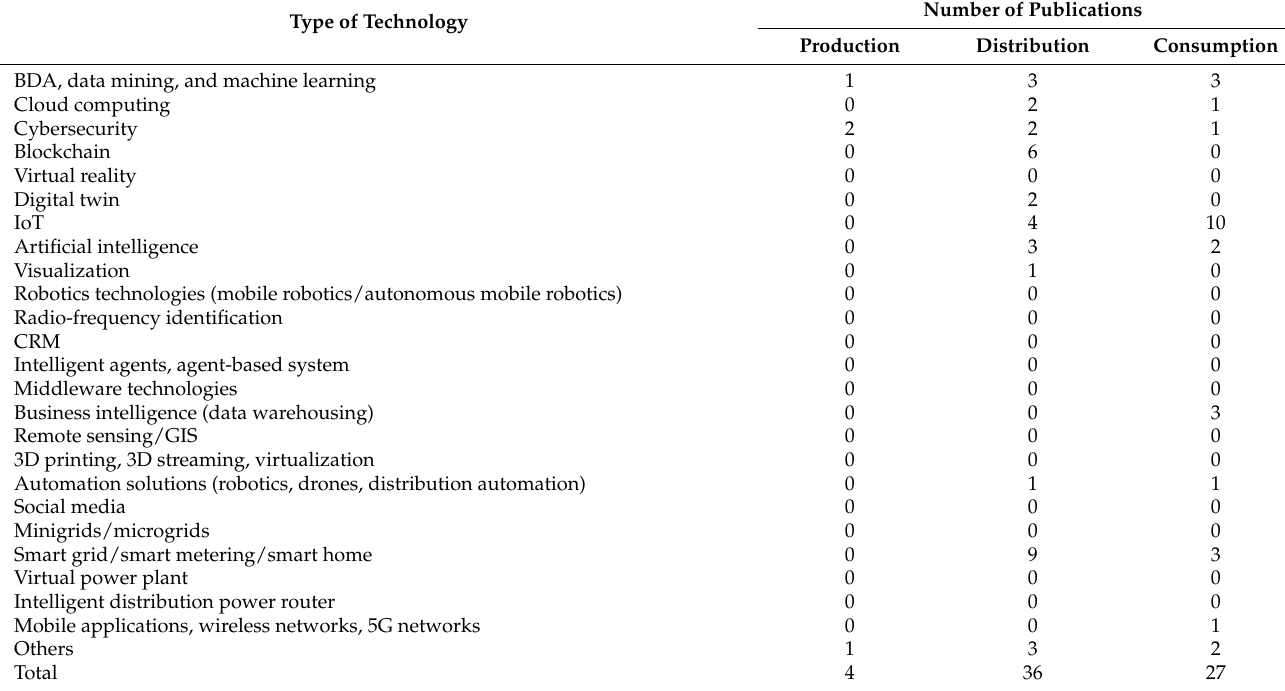
Table 11. Distribution of the technologies and systems by energy sector 1 .